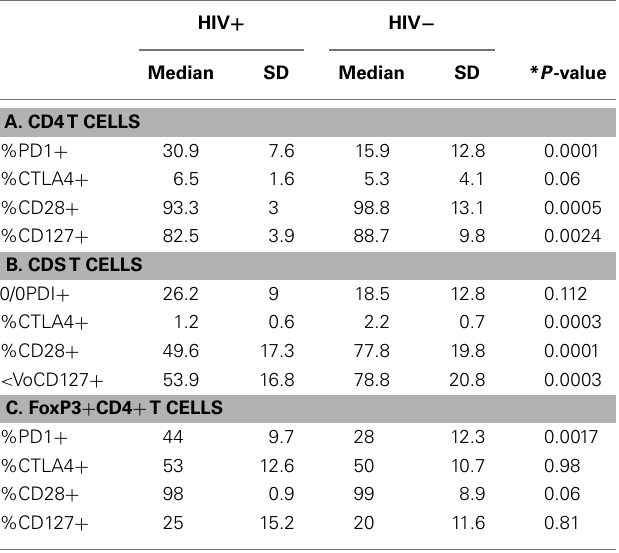
Table 2 | Phenotype comparison of CD4 and CD8T cells from HIV + and HIV − subjects .